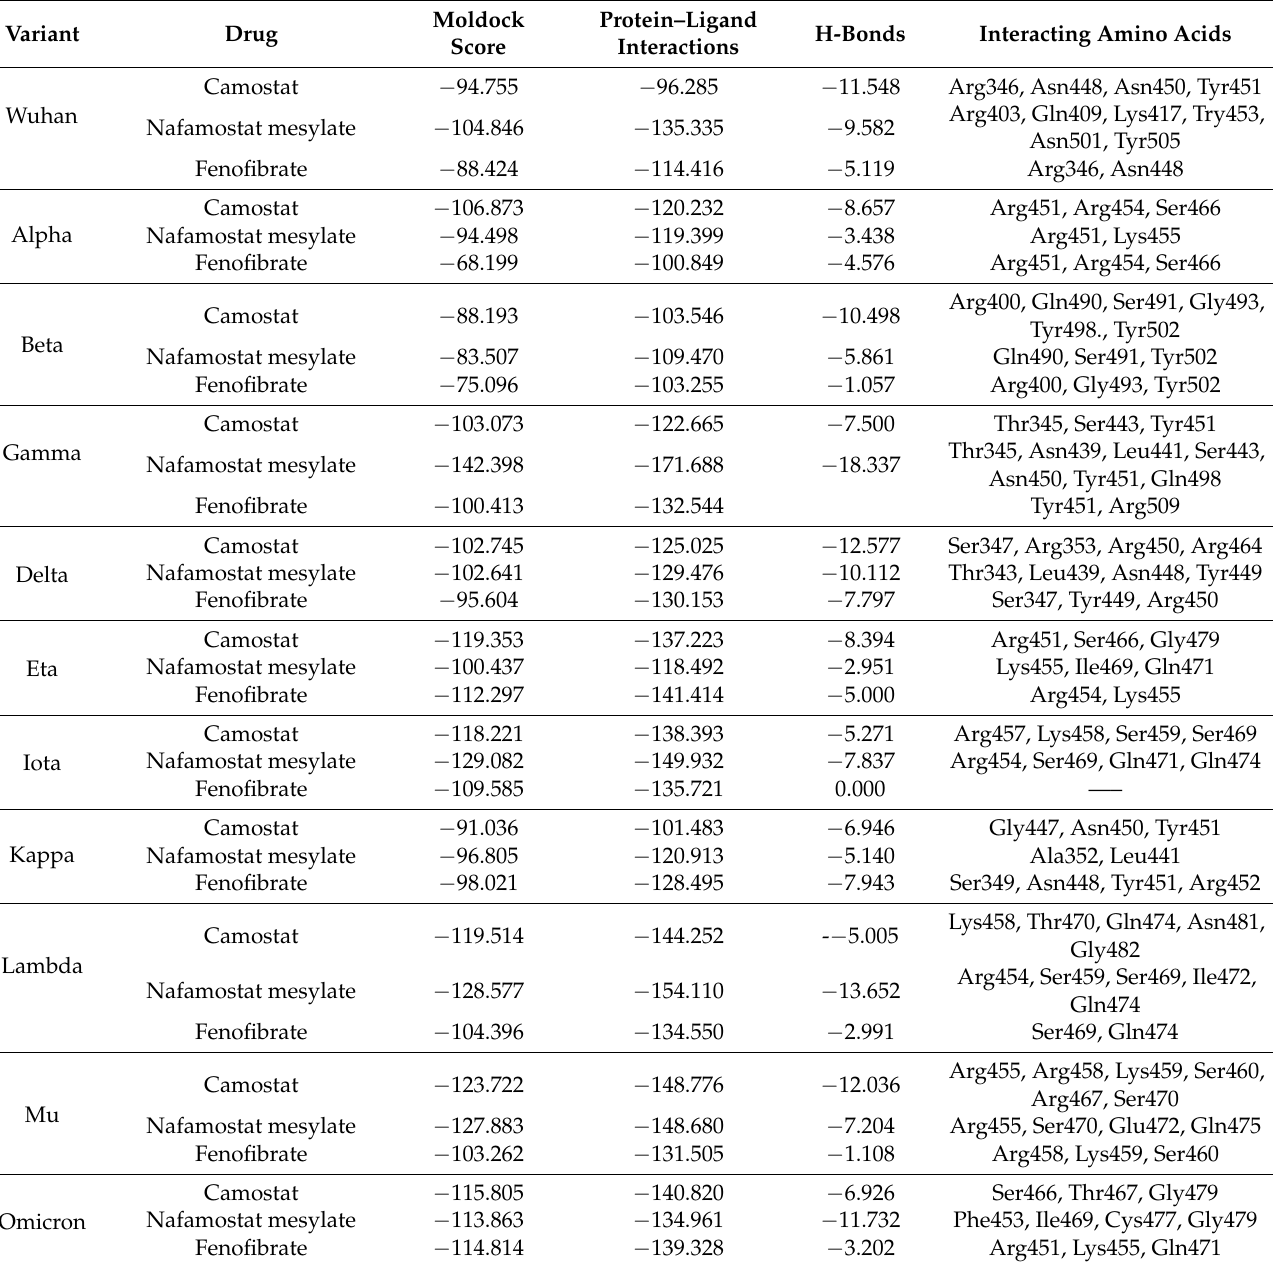
Table 1. Docking of camostat, nafamostat mesylate and fenofibrate to the S1 protein of different SARS-CoV-2